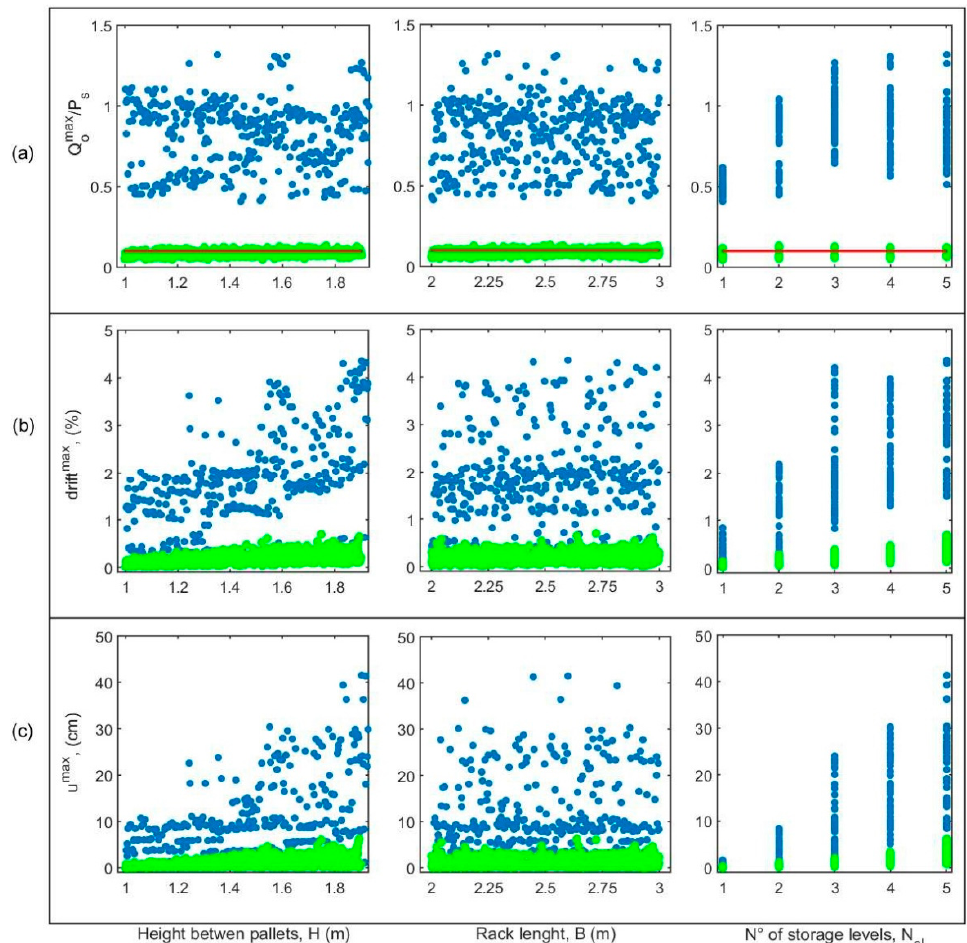
Figure 9. Scatter Plots of: ( a ) the maximum normalized base shear load ( Q o ), ( b ) drift of the top of rack respect to its base, and ( c ) displacement ( u max ) of FBR (blue points) and BIR (green points). The red lines in the figures in row ( a ) indicate the minimum seismic coefficient of NCh2369, C min = 0.1.